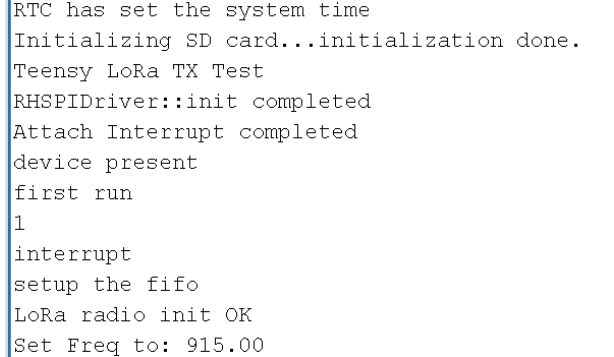
Figure 17. LoRa, RTC and SDcard